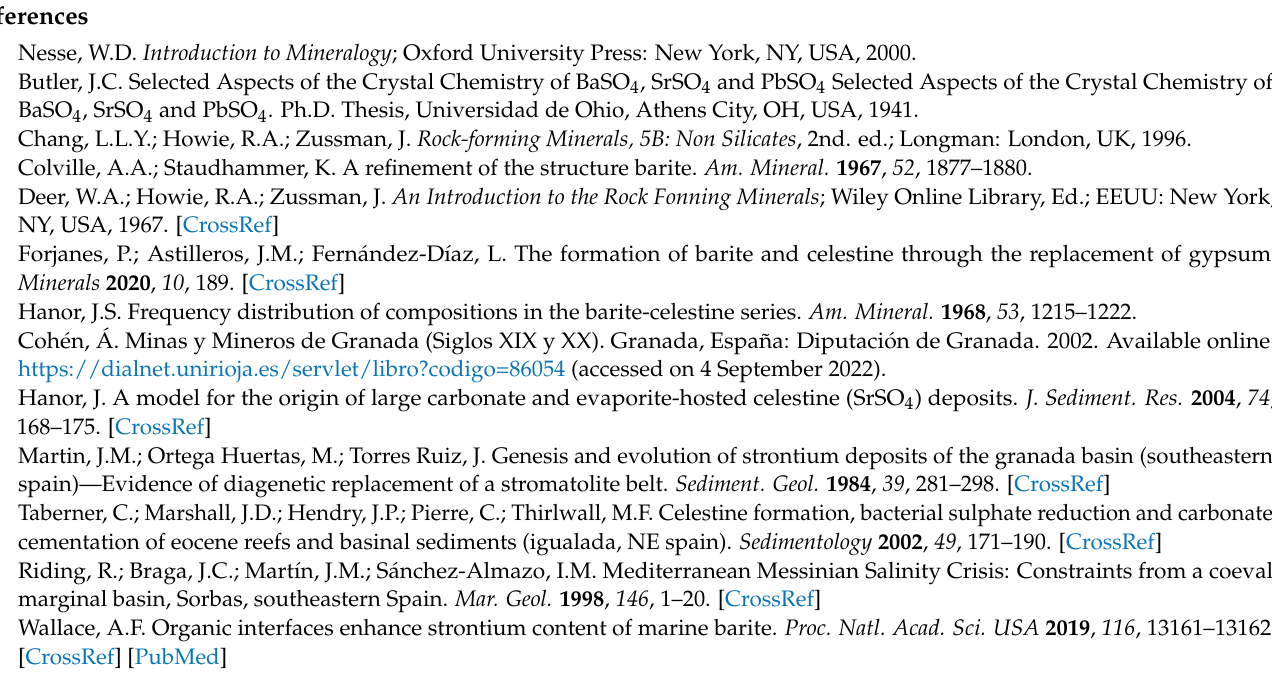
S3: Sample E90. Figure S4: Assembly electric vibrator, Figure S5: Gravimetry fractions, Figure S6: Optical microscopy of celestine crystals replacing carbonate, sample E69., Figure S7: Scanning electron microscopy (a) and compositional SEM map of E69 sample (b).,Figure S8: Granulometry results, % mass r and f i to each diameter (mm) in E60, E69, E92 samples, Figure S9: X-ray fluorescence (representative XRF spectra of one of the samples (E69), Figure S10: Correlation Al 2 O 3 /SiO 2 obtained in XRF.,Figure S11: Rietveld refinement of X-ray diffraction data used for quantitative mineral analysis, Figure S12: Linear regression model between % Sr(SO 4 )Ba obtained by XRF and DRX, Figure S13: Linear regression model between % CaCO 3 obtained by XRF and DRX, Figure S14: % CaCO 3 by TGA vs. % CaCO 3 by XRF or DRX; Table S1: Granulometry results, % mass r and f i to each diameter (mm) in E60, E69, E92 samples, Table S2: Comparative % CaCO 3 by DXR, XRF and TGA